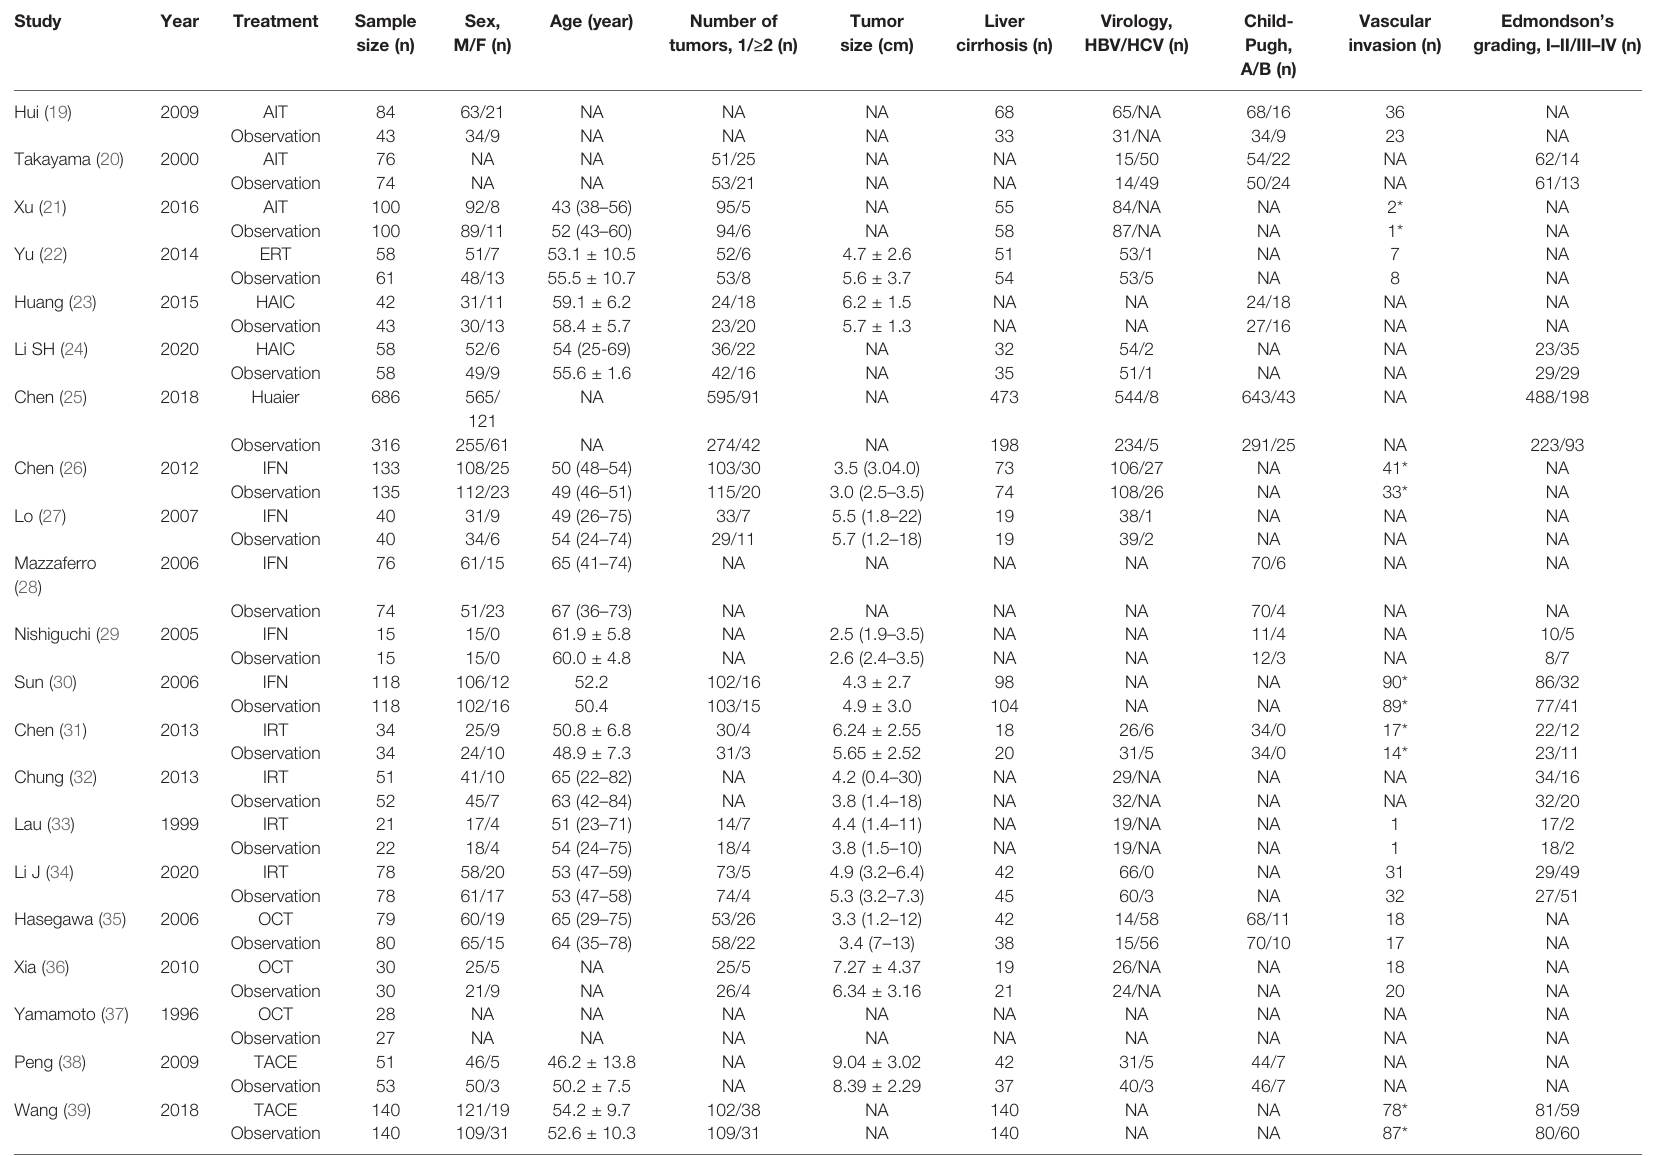
TABLE 1 | The baseline characteristics of included